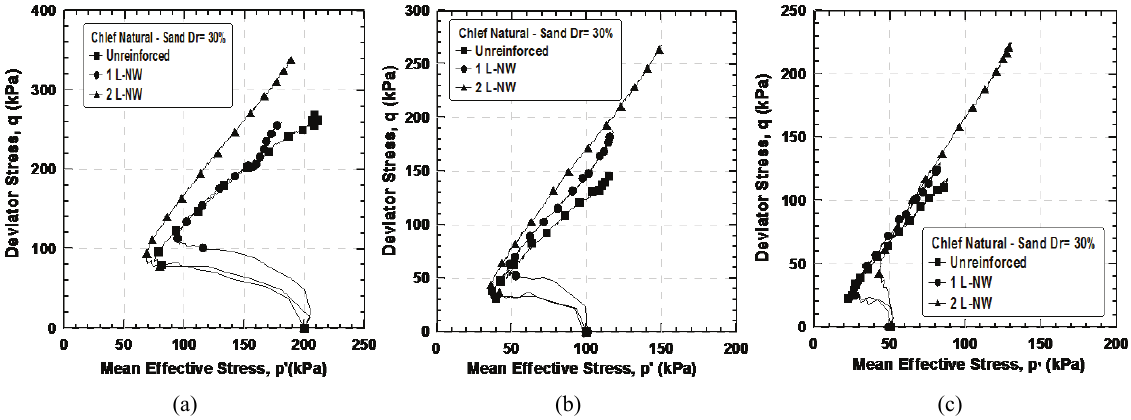
Fig. 10. Effective stress path curves of sand unreinforced and reinforced with various number of geotextile layers